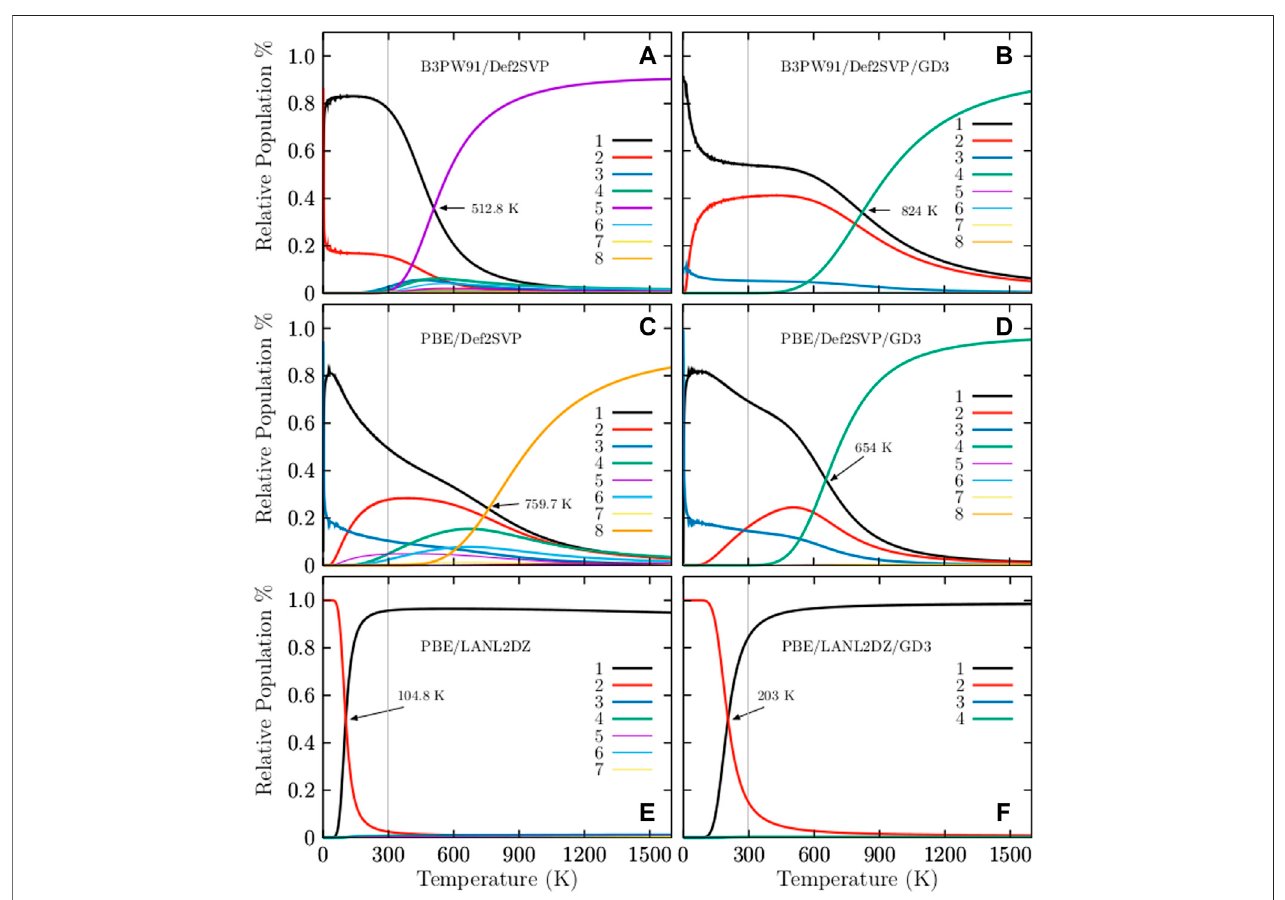
FIGURE 2 | (Color online) The occurrence probabilities for temperatures ranging from 20 to 1500 K at six different levels of theory: (A) B3PW91-D3/def2-SVP, (B) B3PW91-D3/def2-SVP, (C) PBE/def2-SVP, (D) PBE-D3/def2-SVP, (E) PBE/LANL2DZ,and (F) PBE-D3/LANL2DZ.Thecases (B , D) ,and (F) arecomputedconsidering the D3 Grimme dispersion. In all cases, the effect of the dispersion on the solid-solid transformation point in the temperature scale is large for the Cu 38 cluster. At hot temperatures the dominant structureisanamorphous geometry depictedin Figure 1D ,whereas, the TOstructure depicted in Figure1A isthestrongly dominant structure at cold temperatures and at the B3PW91-D3/def2-SVP level of theory.